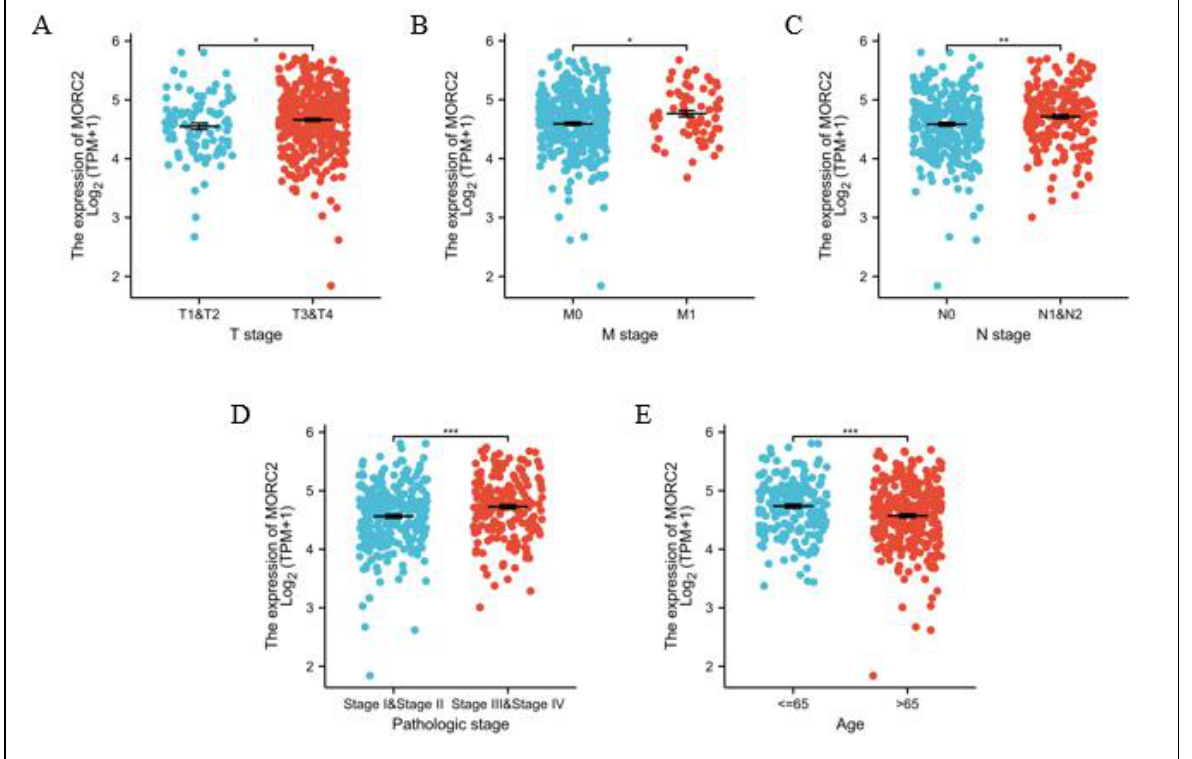
Figure 5. MORC2 expression is associated with clinicopathological characteristics in CRC patients. ( A – F ) The Wilcoxon rank sum test was applied to analyze the association of MORC2 expression with clinical T stage, clinical M stage, clinical N stage, pathologic status, and age. * p < 0.05, ** p < 0.01, *** p < 0.001. Red and blue represent different coordinates.